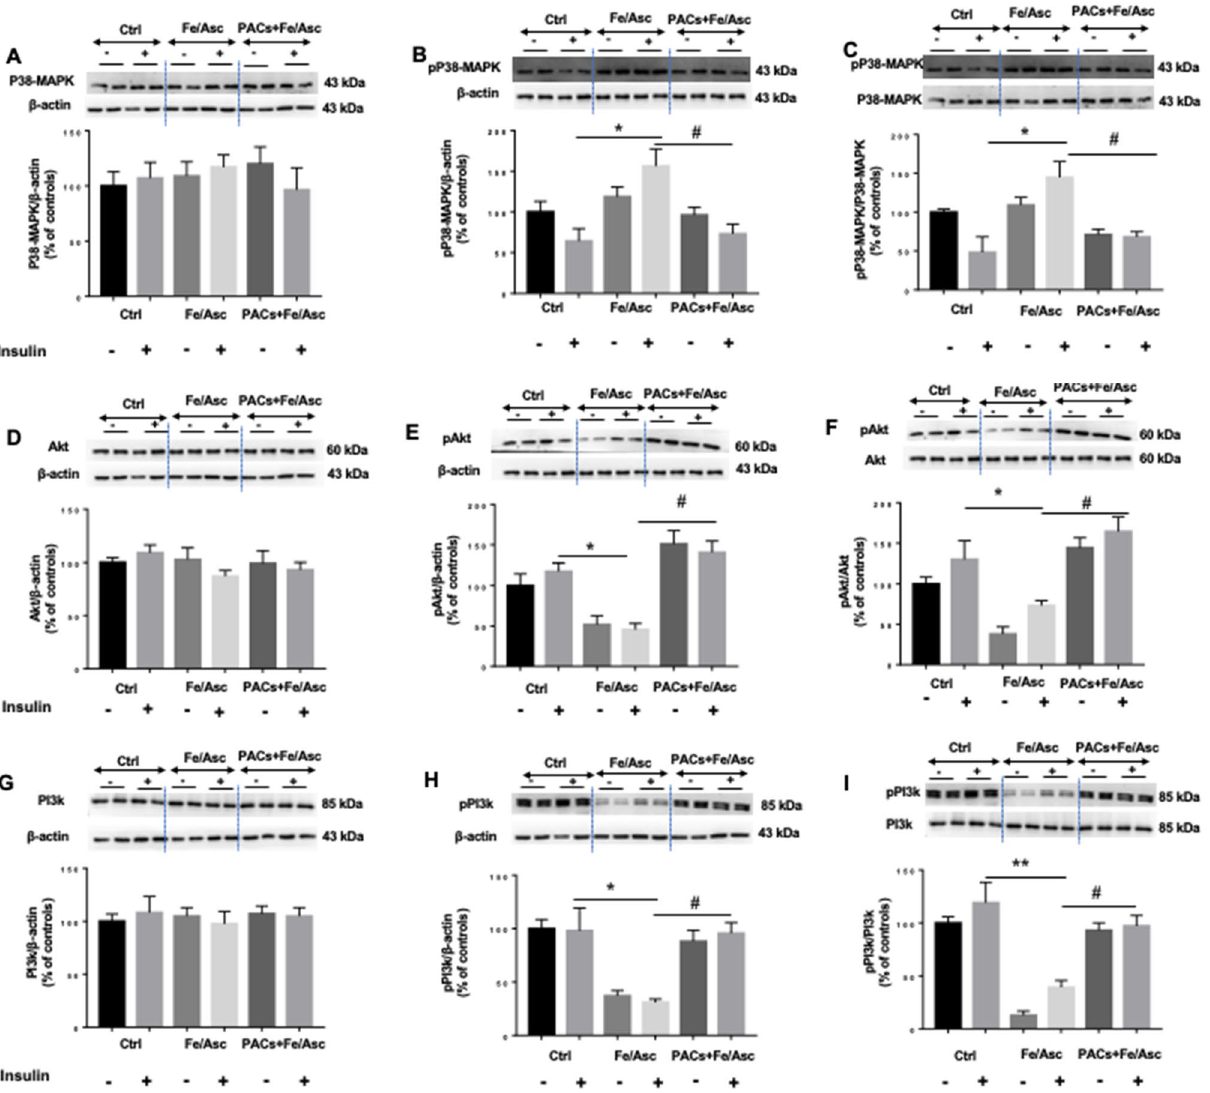
Figure 7. Effects of PACs on insulin sensitivity in Caco-2/15 cell line. Proanthocyanidins (PACs, 250 µg/mL) were added to the apical cell compartment for 24 h prior to treatment with Fe/Asc (200 µM/2 mM) for 6 h at 37 °C. Two hours before the end of the 6 h-incubation with Fe/Asc mixture, insulin (100 nM) was added to evaluate insulin sensitivity. The protein expression of ( A ) p38-MAPK, ( B ) phospho p38-MAPK, ( D ) Akt, ( E ) phospho Akt, ( G ) PI3k and ( H ) phospho PI3k was evaluated by Western blot. The ratios ( C ) phospho p38- MAPK/p38-MAPK, ( F ) phospho Akt/Akt and ( I ) phospho PI3k/PI3k were then calculated. Results represent the means ± SEM of 3 independent experiments each in duplicate. A representative Western blot is shown, illustrating an experiment in triplicate on the same gel and with the same exposure. *P < 0.05 vs +/− insulin untreated cells (ctrl). # P < 0.05 vs Fe/Asc +/− insulin treated cells. p38-MAPK p38-mitogen activated protein kinase, PI3k phosphoinositide 3-kinase, Akt protein kinase ARE, and accelerates transcription of antioxidant enzymes 39 . According to our data, the treatment of Caco-2/15 cells with PACs repressed Keap1 and likely allowed NRF2 to translocate to the nucleus allowing binding to ARE (core sequence: 5 ′ TGACnnnGC3 ′ ) in the promoter region of antioxidant genes (SOD2 and GPx), resulting in stimulation of their transcription and coordinated up-regulation. In line with these data, the phenolic resveratrol compound prevented OxS in H 2 O 2 -treated rheumatoid arthritis fibroblast ‐ like synoviocytes by promoting expres- sion of NRF2 and decreasing expression of Keap1 40 . Additionally, according to Kanzaki et al., the activation of antioxidant and cytoprotective enzymes can be associated with NRF2/Keap1 ratio 41 . As expected from the amelioration of OxS, PACs significantly lowered inflammation as evidenced by the downregulation of TNFα and COX2. Because NF-κB is a key regulator of proinflammatory cytokines, we exam- ined its response to PACs. In line with the trend of inflammatory agents, PACs abrogated Fe/Asc-mediated NF-κB induction and reduced NF-κB/IκB ratio. Thus, we may reasonably assume that PACs help guard against inflam- mation that endangers intestinal cell functions via the control of NF-κB, the master regulator of inflammatory